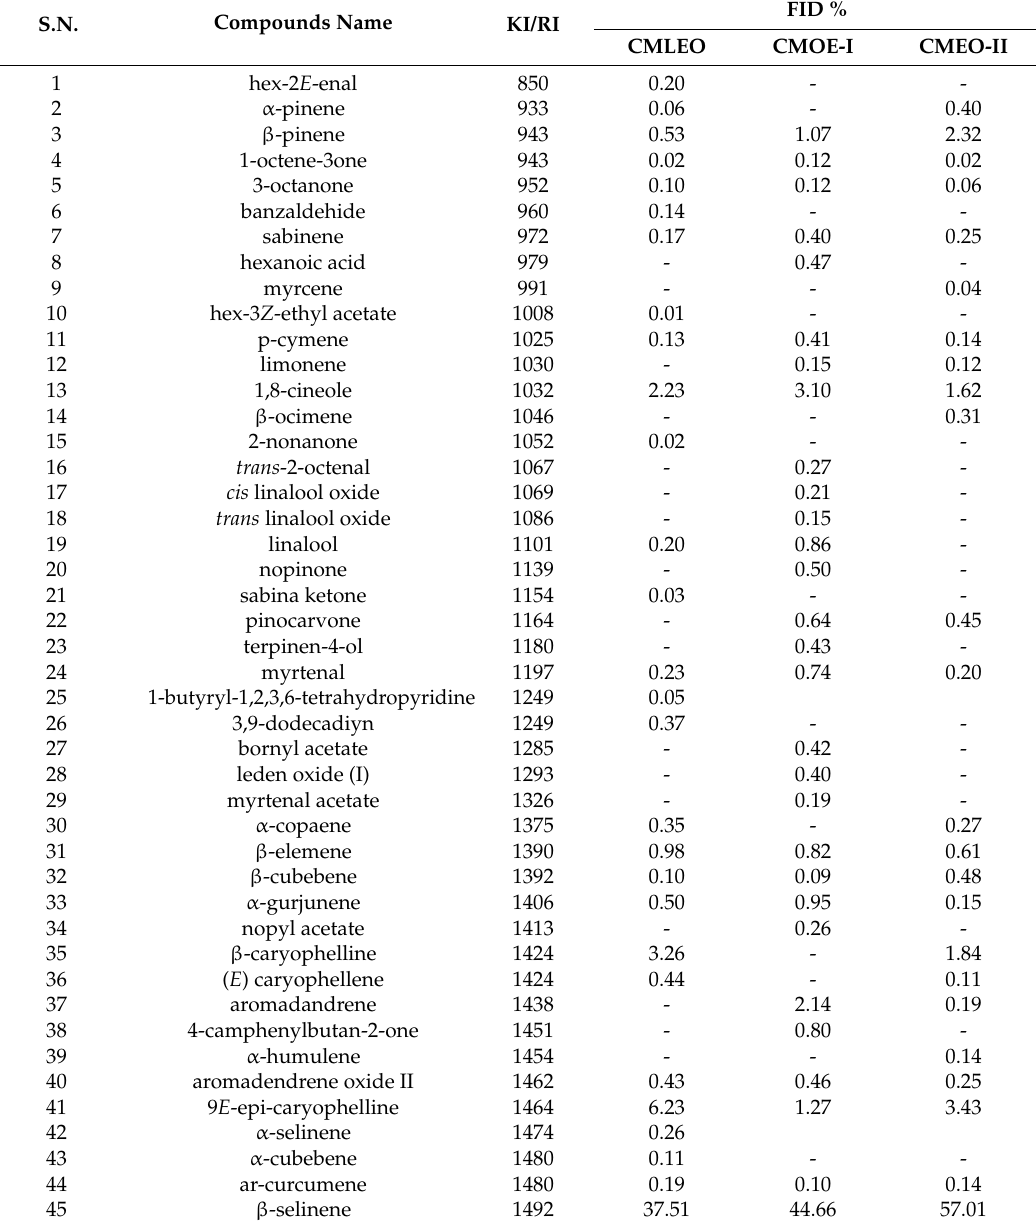
Table 1. Essential oil composition from different parts of Callicarpa macropylla